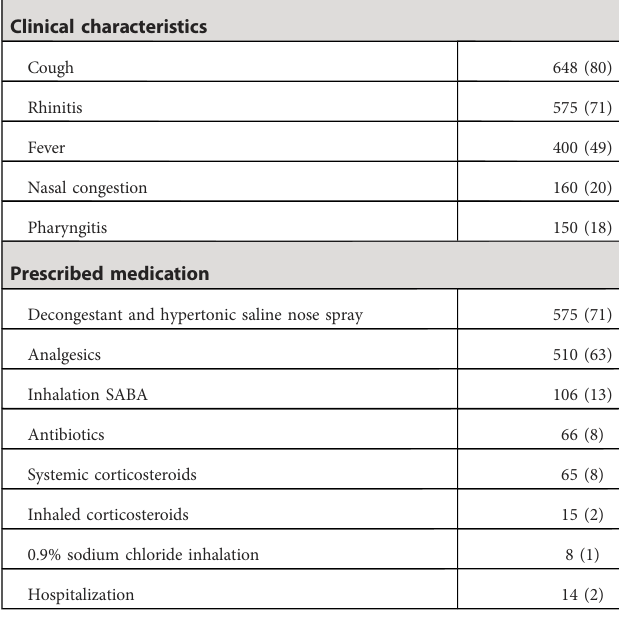
TABLE 2 Clinical characterization and medication. Clinical